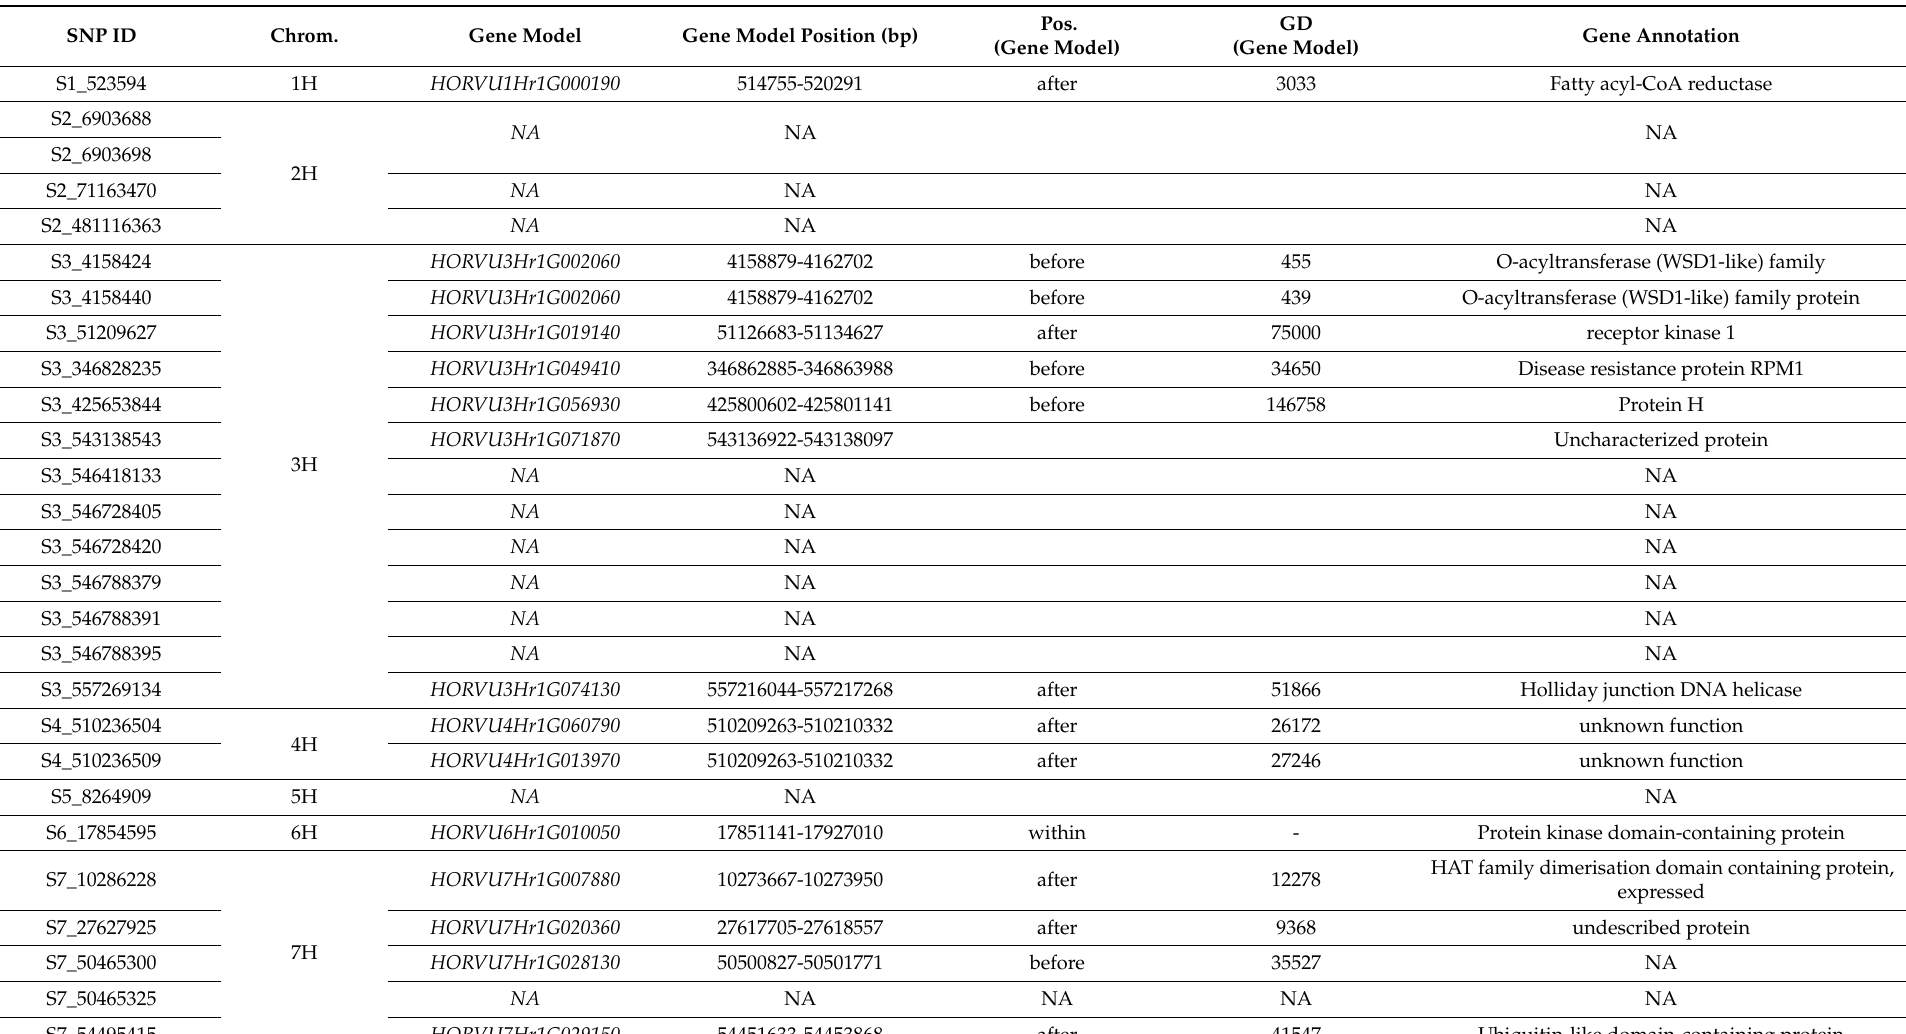
Table 3. The genomic location and annotation of gene models harboring SNP markers significantly associated with loose smut resistance in the 60 Egyptian